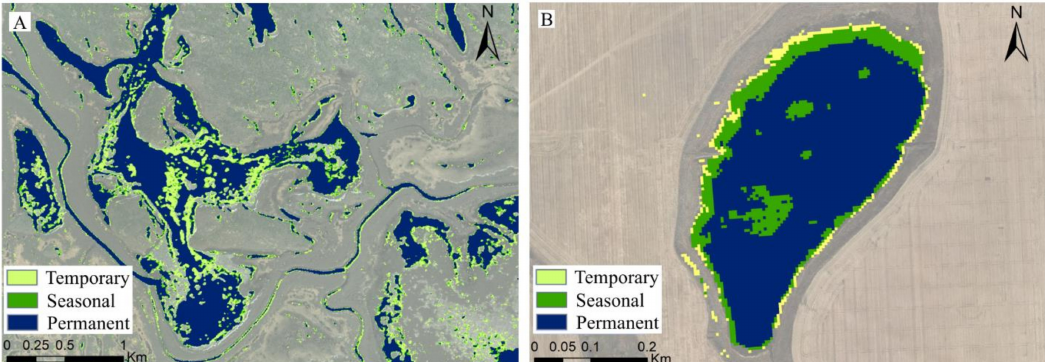
Figure 3. ( A ) Synthetic aperture radar (SAR)-derived hydroperiod (2015) in the Peace-Athabasca Delta, Alberta; ( B ) RapidEye-derived hydroperiod (2015) illustrating optically-based water extent